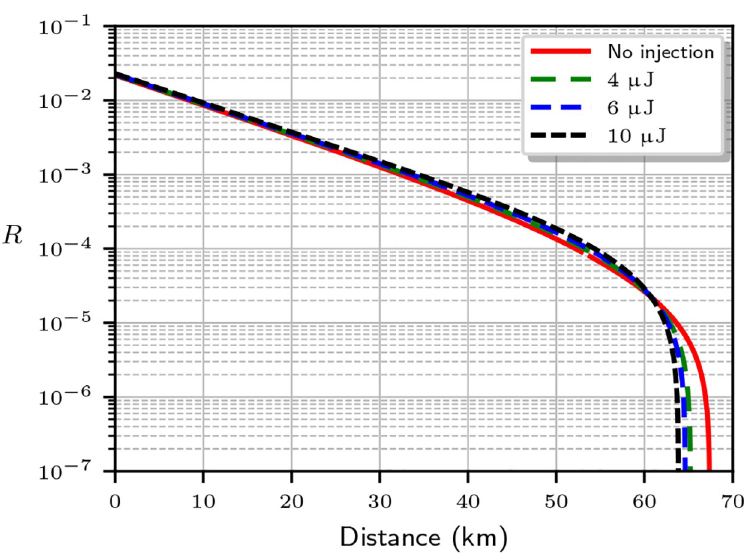
Fig 5. Evolution of the secret key rate R for BB84 with the link distance for an attenuation of 0.2 dB/km. The red line shows the rate limit estimation Alice and Bob make with their available data. The dashed lines show the corrected rate limit when the mean photon number includes the injected photons from an attacker using lasers with different total energies in the 20 ns data pulses. The maximum distance for a secure key becomes smaller at higher laser power. We assumed a detector efficiency η = 0.1 with dark count probability p d = 5 × 10 − 5 and visibility V = 0.99.